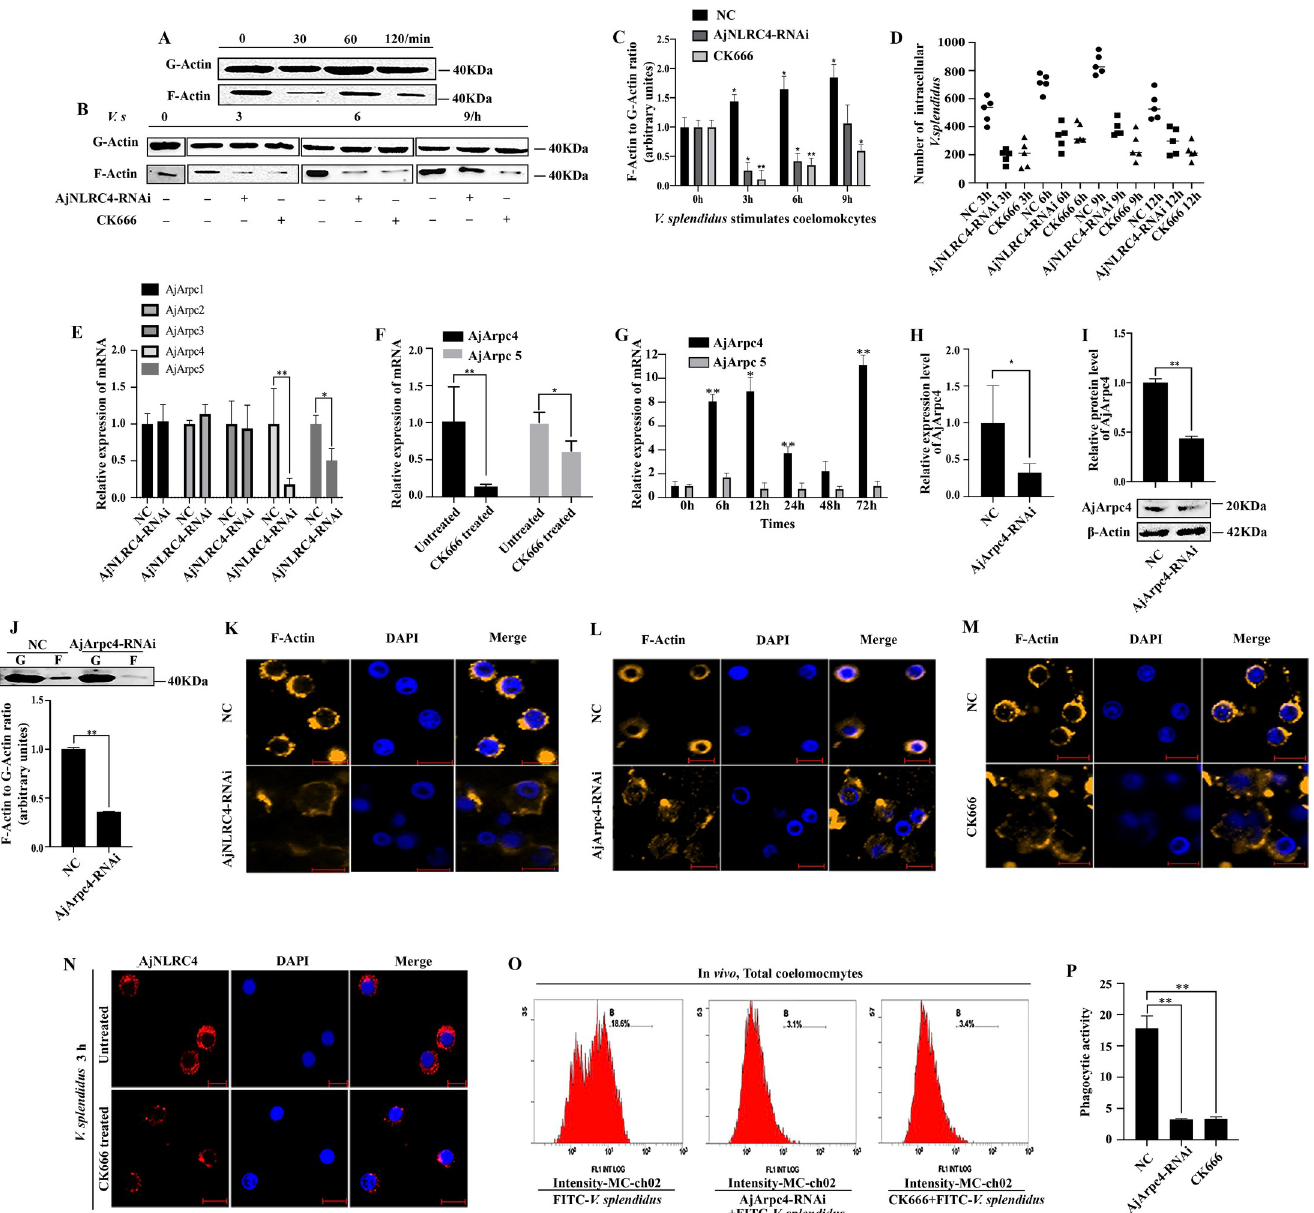
Fig 8. AjNLRC4 mediates the endocytosis of V . splendidus by regulating the Arpc2/3 complex to mediate actin polymerization and cytoskeletal rearrangement. (A) G-actin and F-actin were extracted from the coelomocytes of healthy sea cucumbers. ( B-C) The change in the ratio F-actin/G-actin after treatment with AjNLRC4-RNAi or the cytoskeletal nucleation inhibitor CK666 was detected by western blot. (D) Quantification of the number of V . splendidus cells internalized into coelomocytes. After V . splendidus was coincubated with coelomocytes, the unattached bacterial cells were washed away. The numbers of cells associated with and/or internalized into coelomocytes were counted on solid plates after the detachment of the coelomocytes with trypsin-like enzyme and the lysis of the coelomocytes with Triton X-100. The V . splendidus cells internalized into the coelomocytes were counted after killing the external V . splendidus with gentamicin, detaching the coelomocytes with trypsin-like enzyme and lysing the coelomocytes with Triton X-100. The horizontal bars represent the medians. The p values were calculated by the t test for paired samples, and � p < 0.05 indicated significant differences. (E) AjArpc2/3/4/5 mRNA expression levels were measured after treatment with AjNLRC4-RNAi. The graphs are representative of three independent assays, and the proportions were calculated from those three assays, � p < 0.05, �� p < 0.01. (F) AjArpc4/5 mRNA expression levels were measured after CK666 treatment. The graphs are representative of three independent assays, and the proportions were calculated from those three assays, � p < 0.05, �� p < 0.01. (G) , Analysis of AjArpc4/5 expression in V . splendidu s-infected sea cucumbers. The vertical bars represent the mean ± S.D. (N = 3). (H-I) The efficiency of AjArpc4-RNAi in coelomocytes was determined using qPCR and western blotting analysis. The graphs are representative of three independent assays, and the proportions were calculated from those three assays, � p < 0.05. (J) western blotting revealed the change in the ratio F-actin/G-actin after treatment with AjArpc4-RNAi. The graphs are representative of three independent assays, and the proportions were calculated from those three assays, �� p < 0.01. (K-M) Immunocytochemistry was performed after knockdown of AjNLRC4 or AjArpc4 or treatment with CK666 (actin polymerization inhibitor)